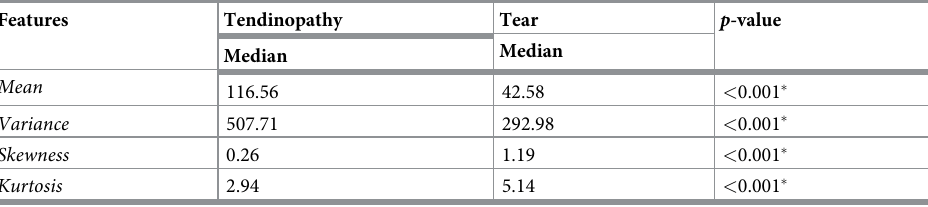
Table 1. The test results of intensity features using the Mann-Whitney U-test.